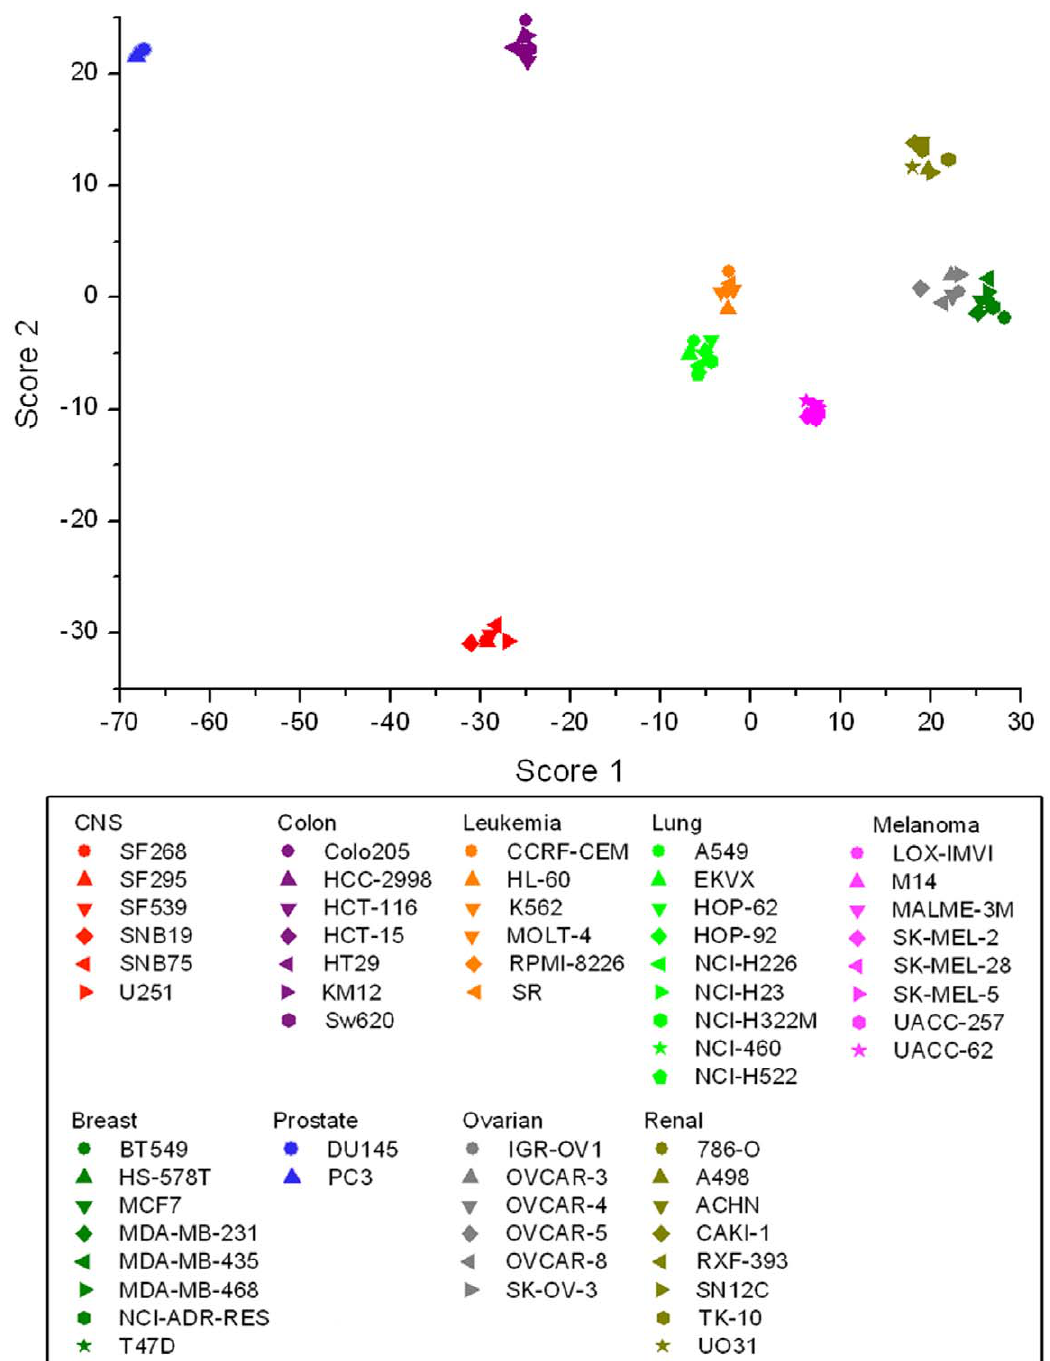
Figure 4. LDA score plot for the intensity kinetic profiles. x-, and y-axis represents the highest and 2 nd highest LDA scores by cell scoring function (Table S2). The 60 cancer cell lines were labelled according to the origin of cancer type; CNS: red, colon: purple, leukemia: orange, lung: green, melanoma: pink, breast: dark green, prostate: pale pink, ovarian: grey, and renal: olive.